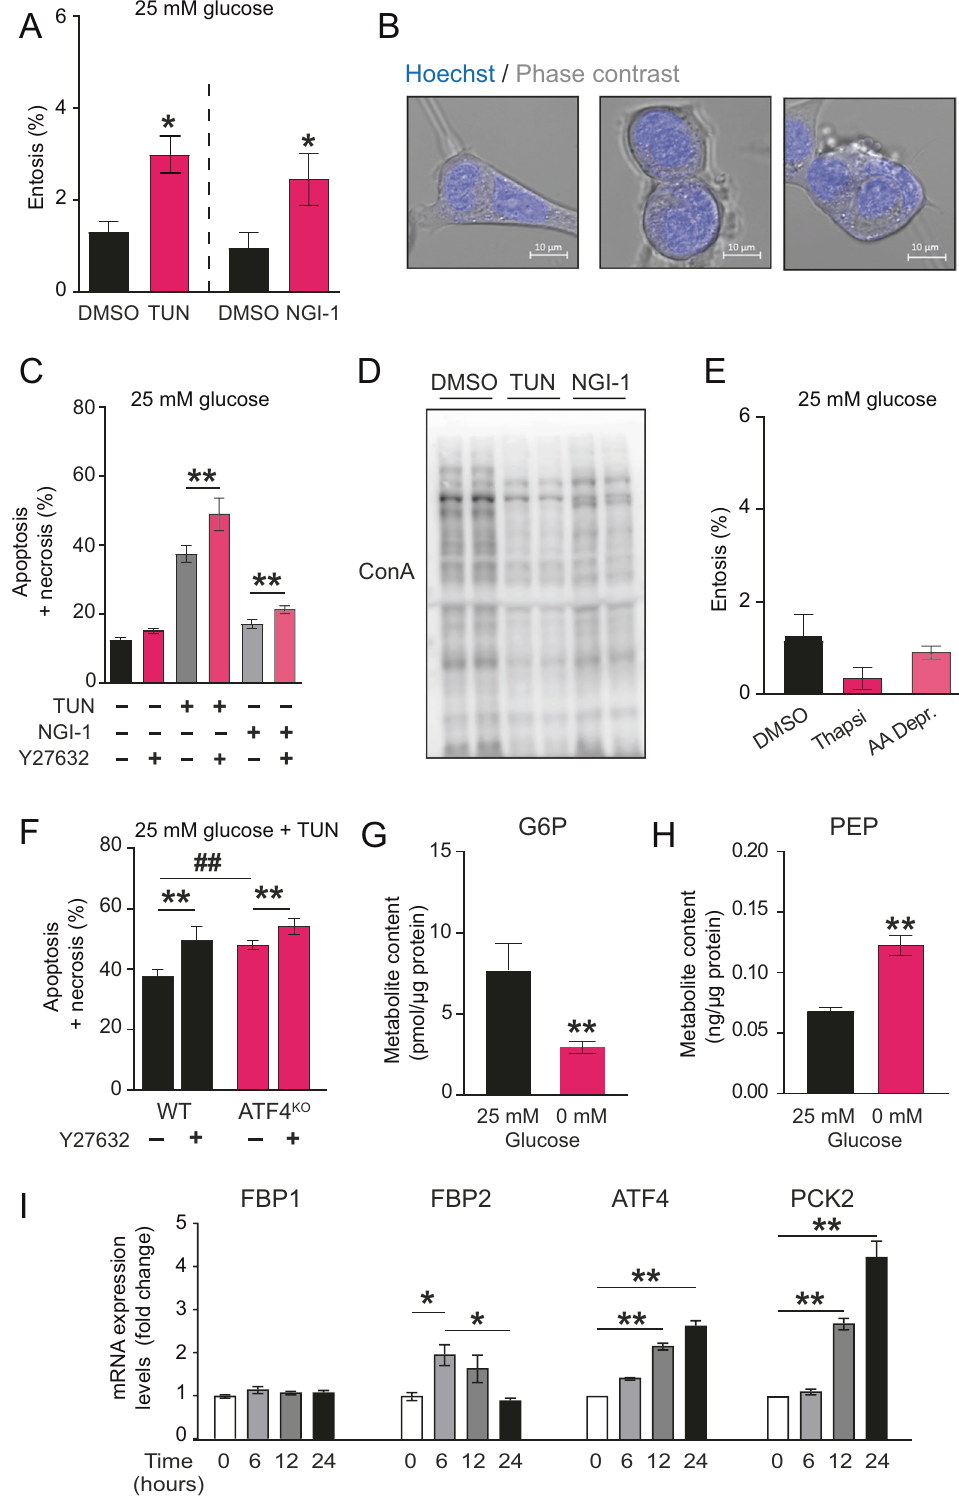
suf fi cient to engage the entosis program. Consistently, tunicamycin- induced entosis in the presence of glucose did not require ATF4, as MCF7 cells with an ATF4 Crispr/ Cas 9 knockout for this transcription factor (ATF4 KO ) also demonstrated increased apoptosis + necrosis in the presence of ROCKi as compared to wild-type MCF7 (Fig.